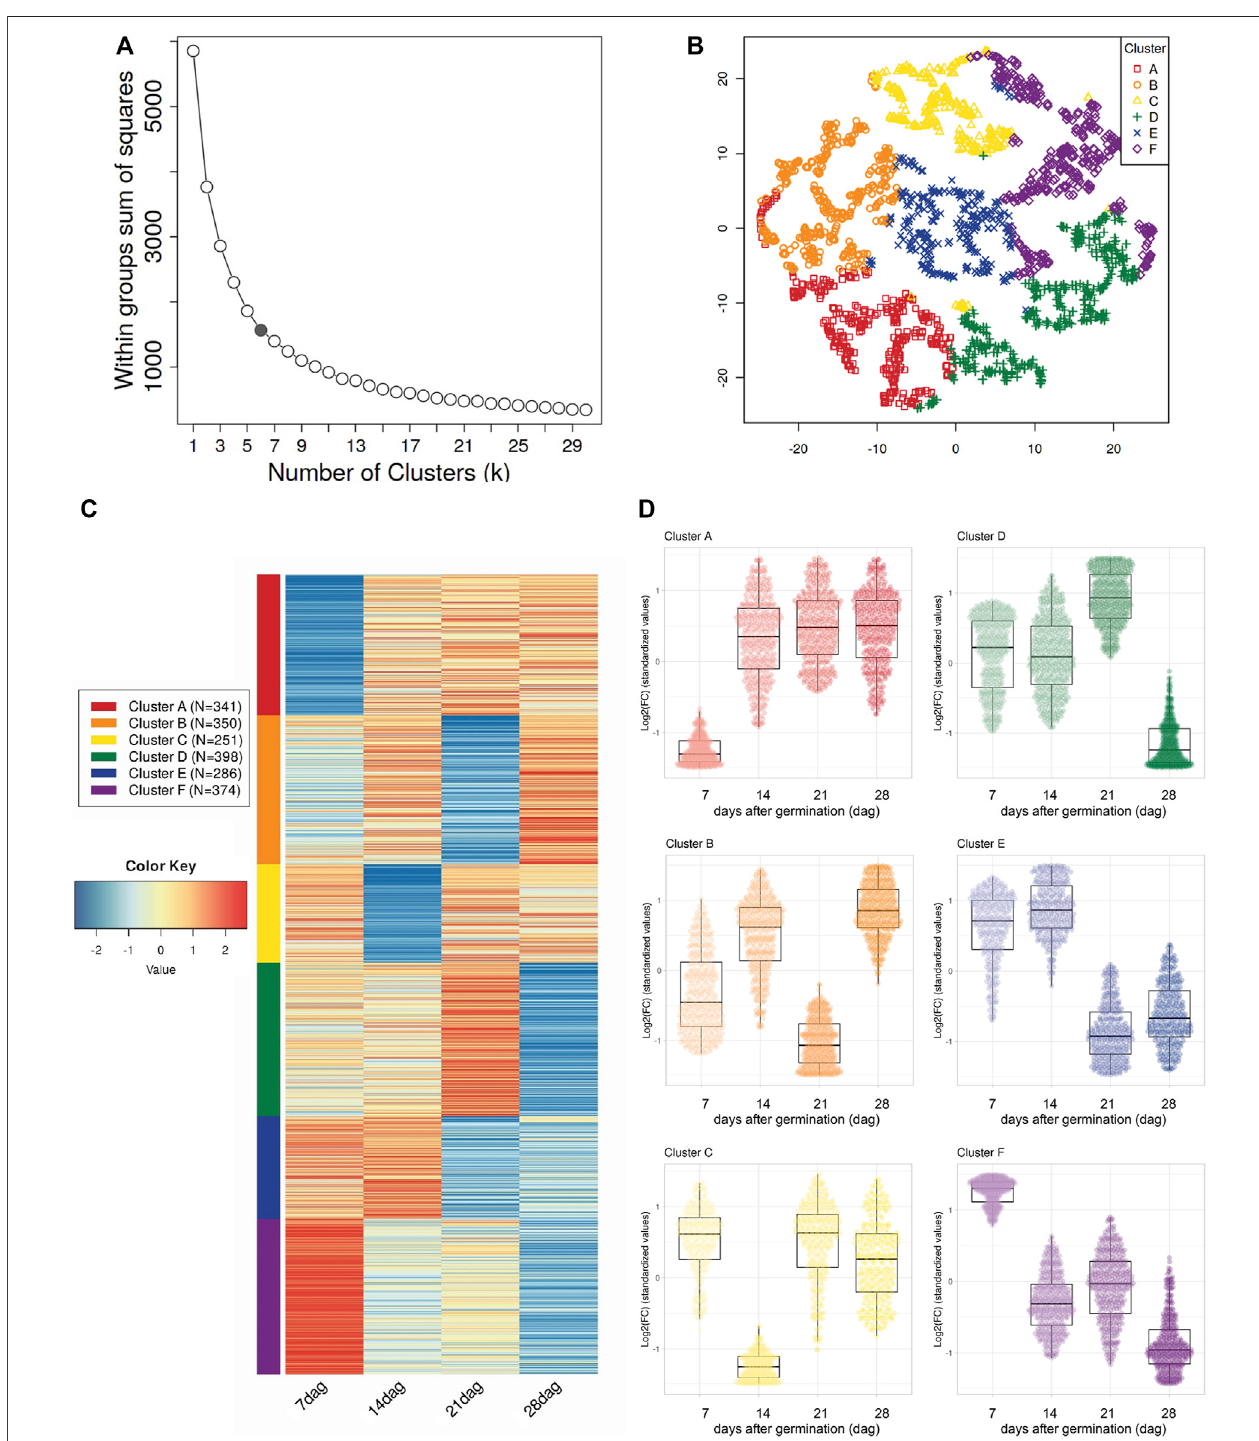
FIGURE 3 | Expression patterns of Differentially Expressed uniGenes (DEG) identi fi ed in the transcriptome of Psittacanthus schiedeanus and involved in the compound endosperm development. (A) Elbowcriterion applied over the curve ofwithin-class sum-of-squaresper number ofclusters. The gray point isconsidered the elbow ( k = 6). (B) t-SNE plot which shows clustering of 2,096 DEGs. The uniGenes coordinates are based on t-SNE dimensionality reduction according to the six expressionpro fi lecategories(ClustersA – F)de fi nedbytheelbowmethod.uniGenesarerepresentedbydistinctmarksshapeandcoloredaccordingtotheircluster membership.In (C) ,aheatmap(Log 2 -transformedFoldChange(FC)values)ofDEGandbelongingtoeachofthesixdistinctlyde fi nedclustersandrepresentedint-SNE map. As indicated at the bottommost, each column in the heatmap corresponds to each of the sampling points or days after germination (dag) [T1 (7 dag); T2 (14 dag);